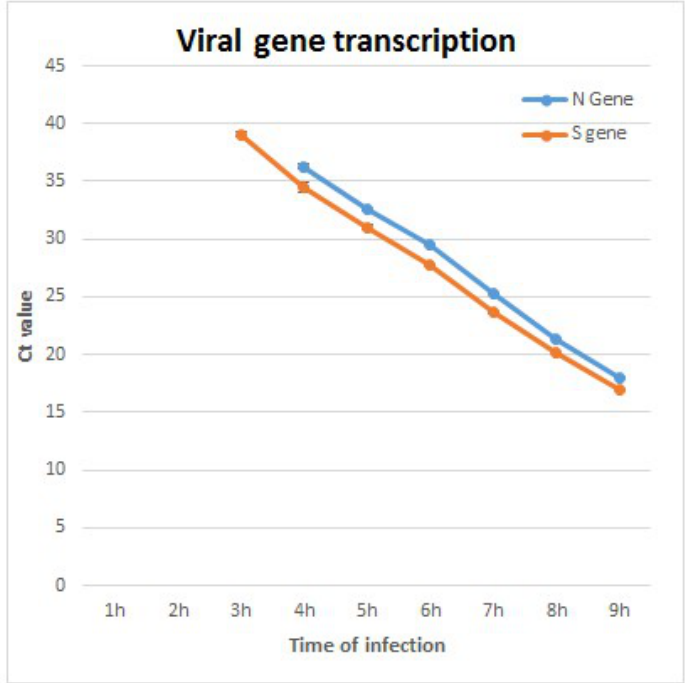
Figure 3. RT real-time PCR analysis results of two viral genes, nucleocapsid (N) and spike (S). Initial detection at 3–4 h post infection (PI) can be seen. As infection progresses, the reduction of Ct values suggests active viral RNA replication. The limit of detection for detection of S gene was 10 pfu/mL, and 100 pfu/mL for N gene. At 1–2 h PI, viral RNA was not detected due to low concentration below the limit of